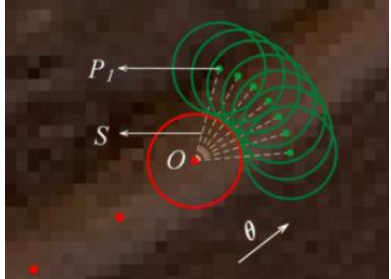
Figure 10. Establishment of matching templates.